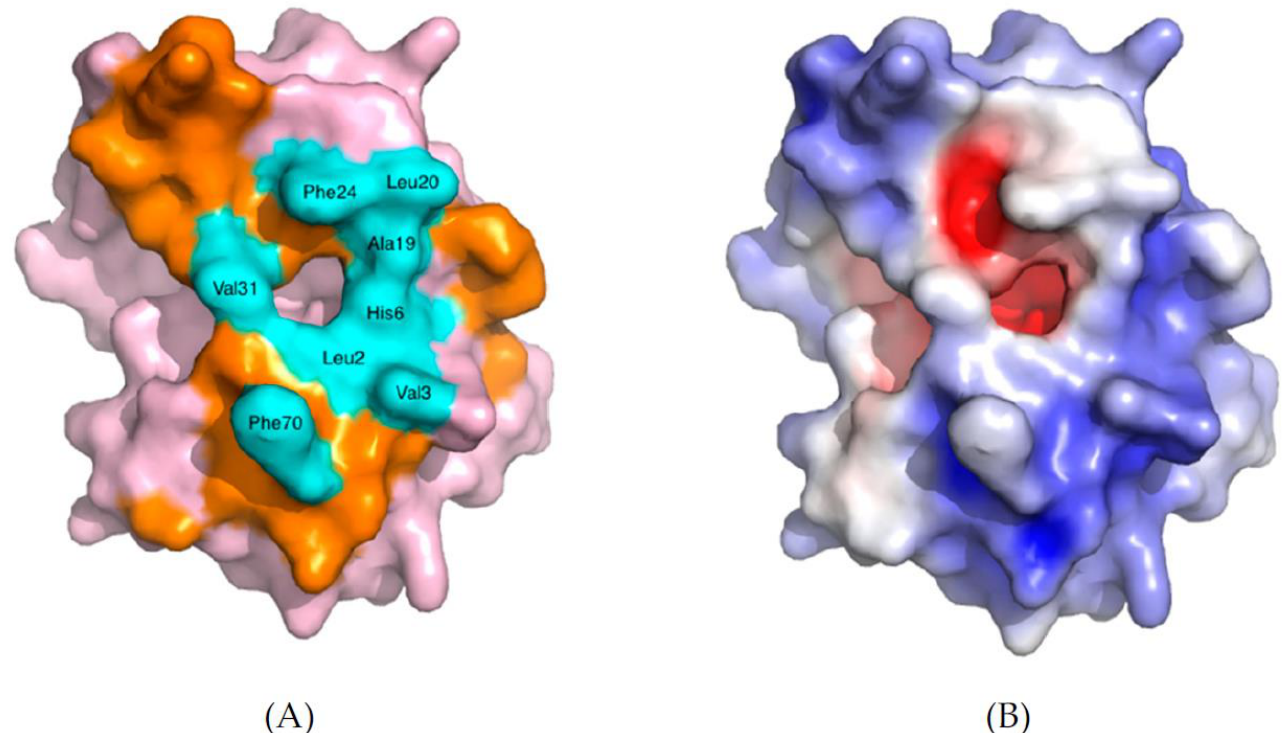
Figure 8. Space-filling model of human group IIA sPLA2 (PDB — 3U8B). ( A ) The amino acids which form the i-face are colored orange, and the ones which create the entrance are highlighted in cyan blue, while the rest of the protein is shown in pink. ( B ) The electrostatic charge distribution is depicted either in blue (positive charge) or in red (negative charge). The white areas charge neutrality (non-polar), which corresponds to the hydrophobic entrance of the left figure. Reprinted from [26].